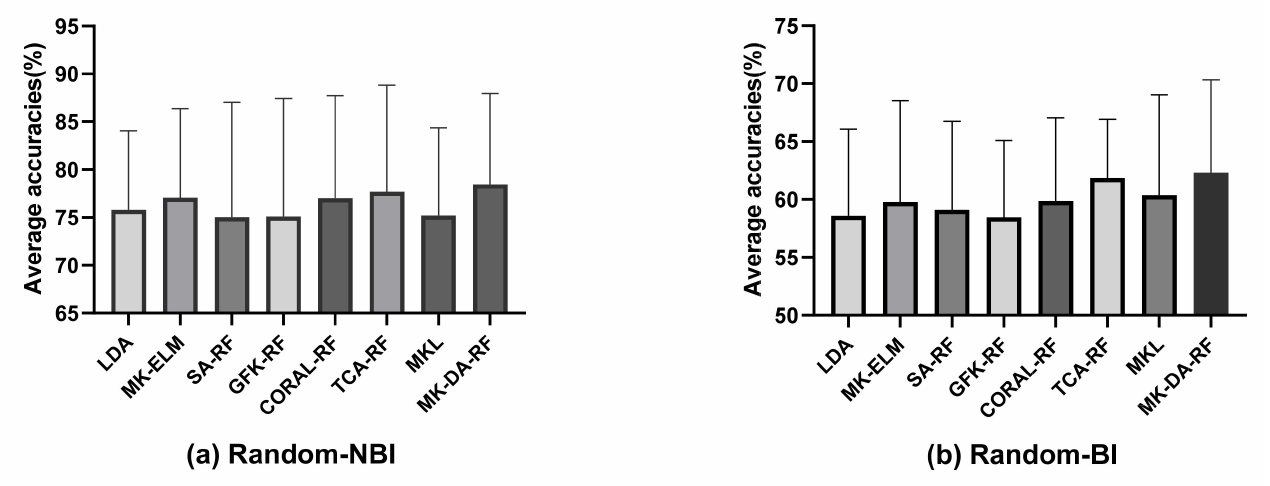
Figure 8. The results of the different distribution adaptation methods in the cross-subject